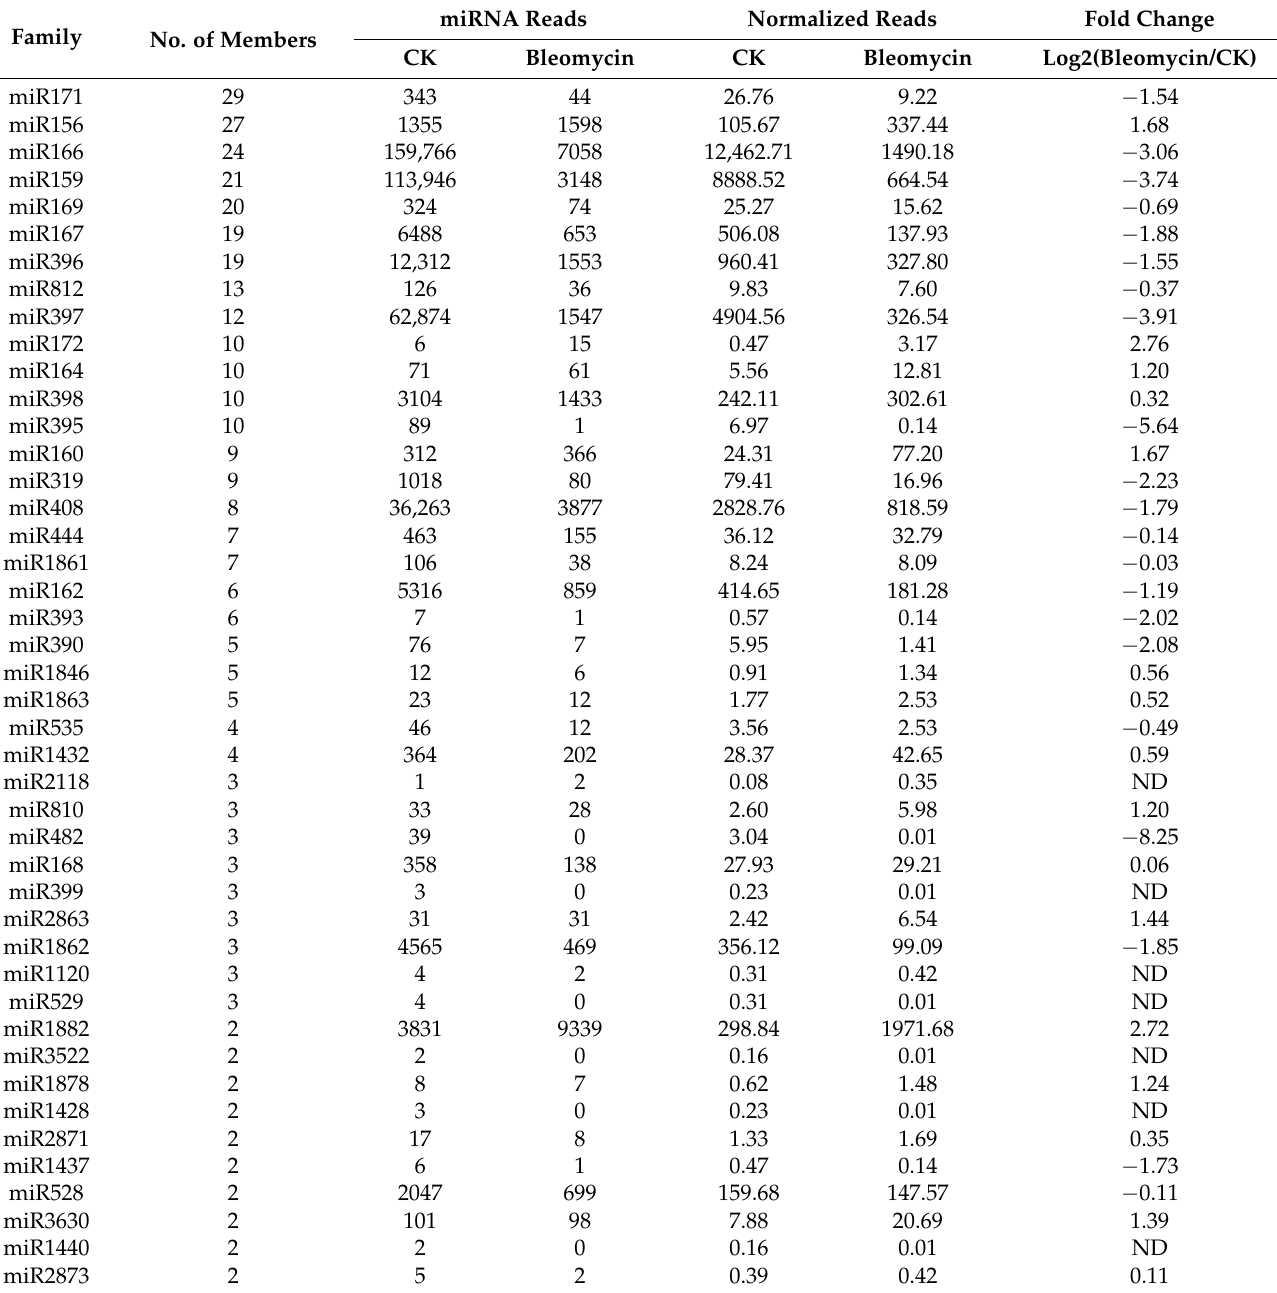
Table 3. Information of known miRNA families and their transcript abundance identified in the two libraries.